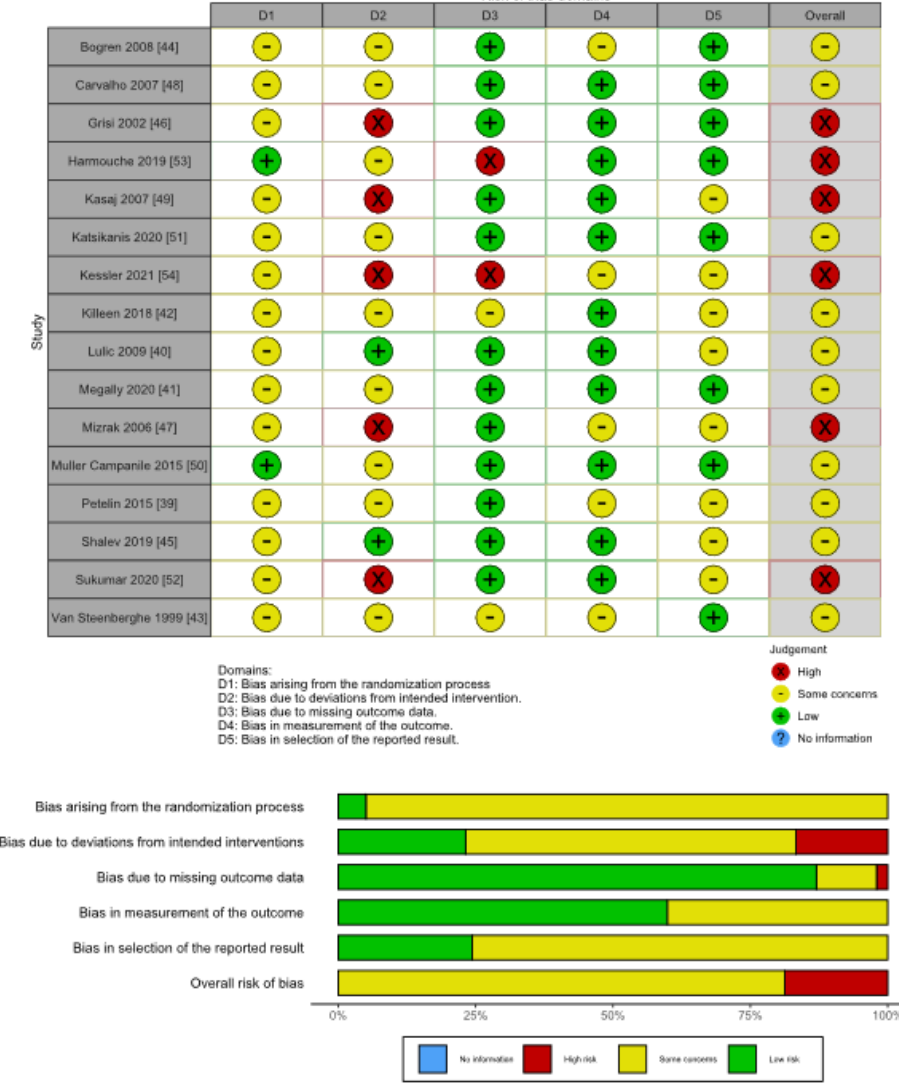
Figure 2. Risk of bias summary of included trials using RoB